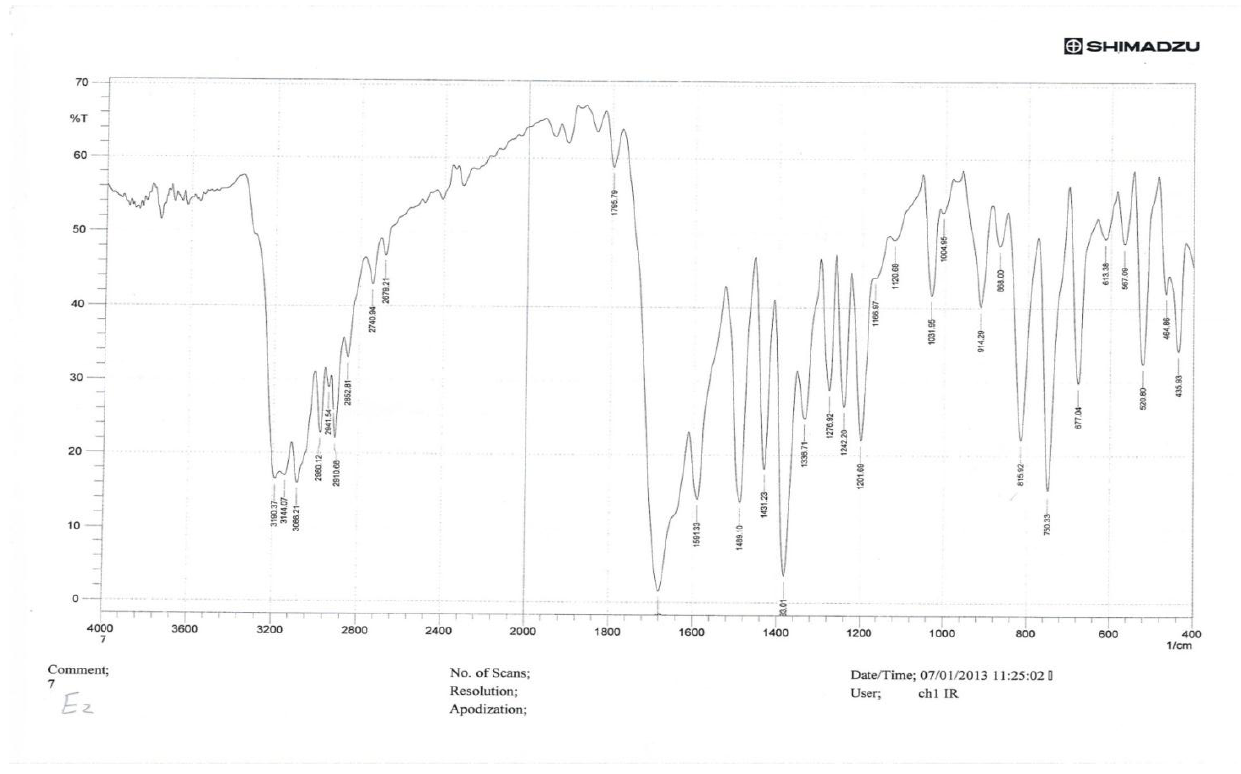
Figure 5: FT-IR spectrum of the isolated alkaloid (E2)